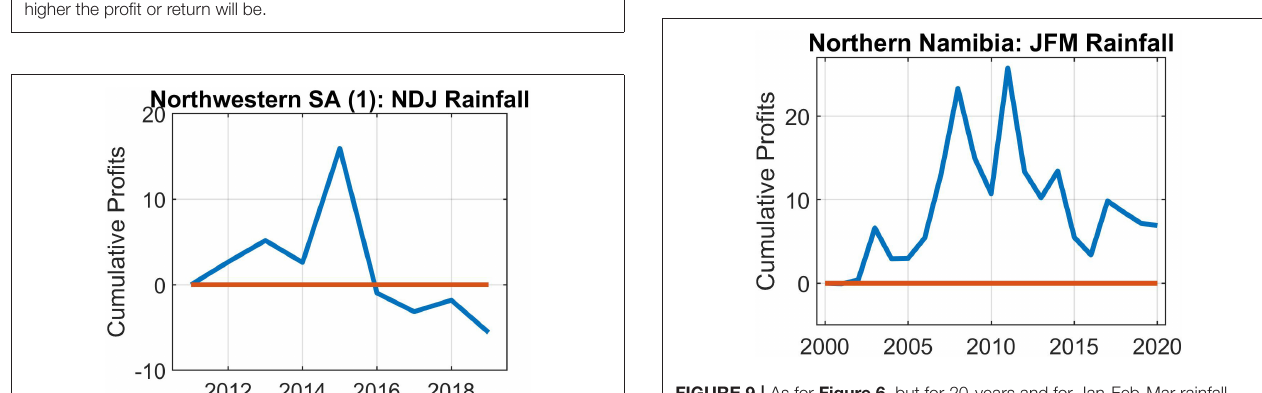
FIGURE 9 | As for Figure 6 , but for 20-years and for Jan-Feb-Mar rainfall forecasts for the farm located in the northern interior of Namibia.